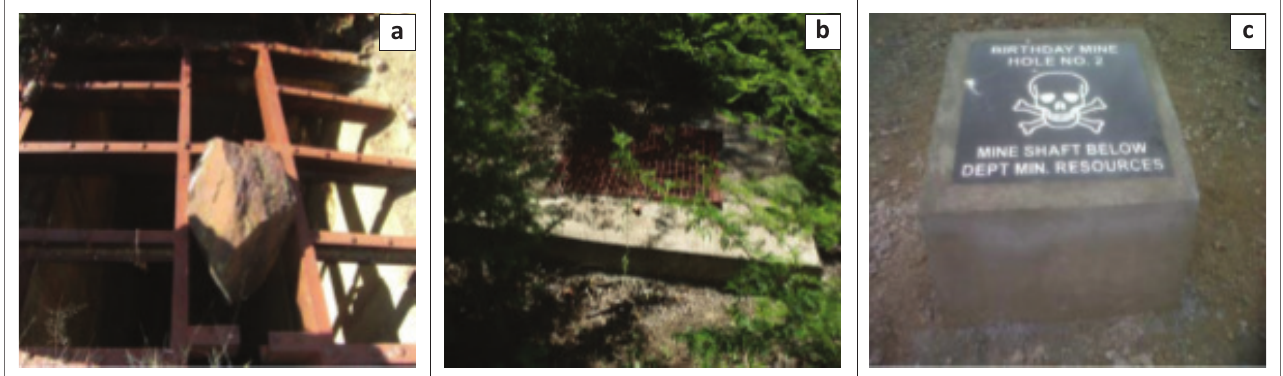
FIGURE 3: Shaft-closing structures at Sutherland goldfield: (a) heavy steel grate, (b) steel wire screen and concrete and (c) concrete plugs with